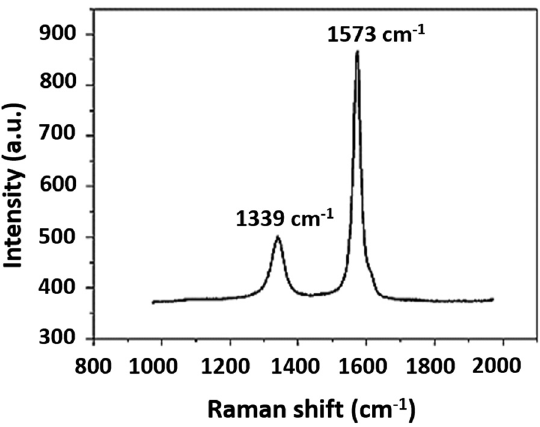
Figure 4: Raman spectra pattern of